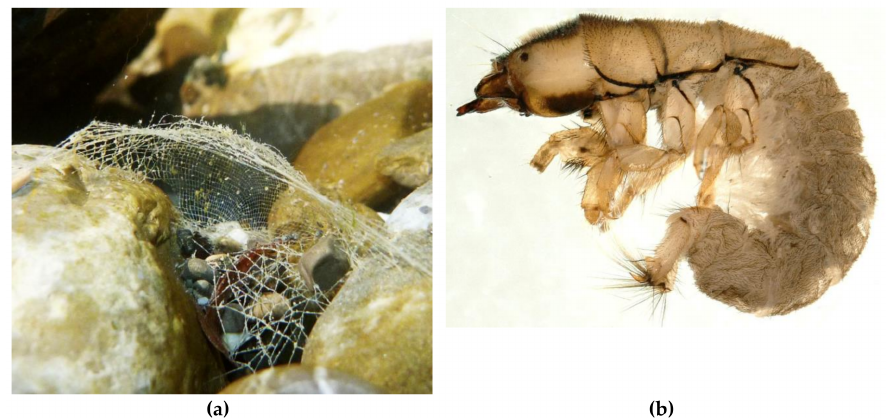
Figure 3. (a) : Filter net and gravel retreat of Hydropsyche sp. (Hydropsychidae) between large stones. (b) : Larva of Hydropsyche bulgaromanorum Malicky, 1977 (Hydropsychidae). Both images © W. Graf.